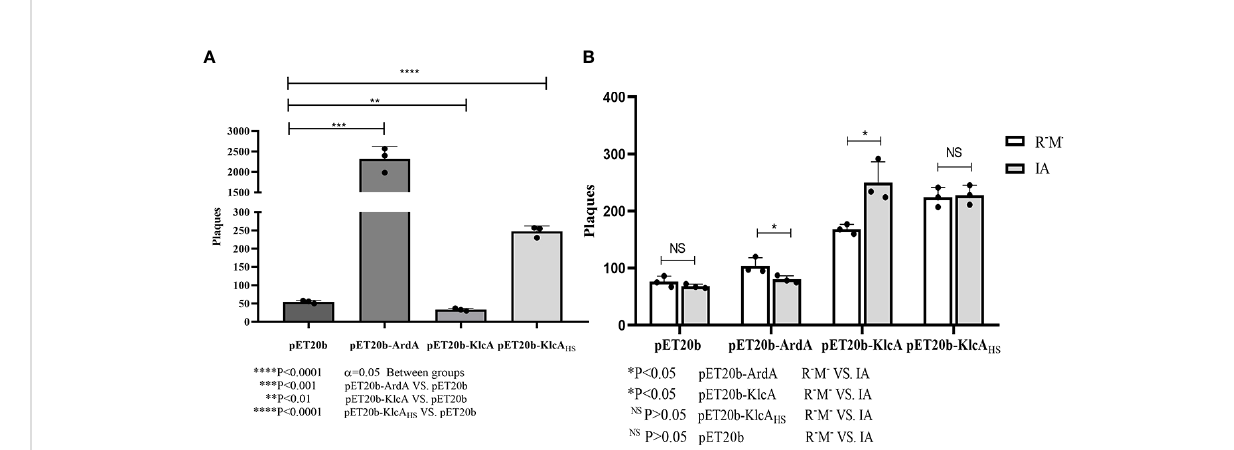
FIGURE 6 (A) X-axis is E. coli strain (IA, EcoKI+) containing four kinds of plasmids, Y-axis is the number of plaques obtained by phage infection. (B) X-axis shows four kinds of phage from E. coli strain (NM1049, EcoKI+) containing four kinds of plasmids, Y-axis shows L phage infection of E. coli strain (IA, EcoKI+) and R - M - strain number of plaques. The assay was repeated in triplicate. Data are the means ±